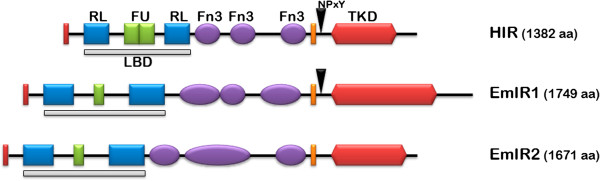
Domain structure of E. multilocularis insulin receptors. Schematic representation of the domain structures of the human insulin receptor (HIR), EmIR1 and EmIR2 according to SMART analyses (Letunic et al., 2012). Displayed are the location and size of the following predicted domains: TKD, tyrosine kinase domain; LBD, ligand binding domain; RL, receptor-L-domain; FU, furin-rich repeat; Fn3, fibronectin 3 domain. The presence of NPXY-motifs for binding of IRS is indicated by an arrowhead. Red bars at the N-terminus represent signal peptides, orange bars represent transmembrane domains. IRS, insulin receptor substrate; SMART, Simple Modular Architecture Research Tool.